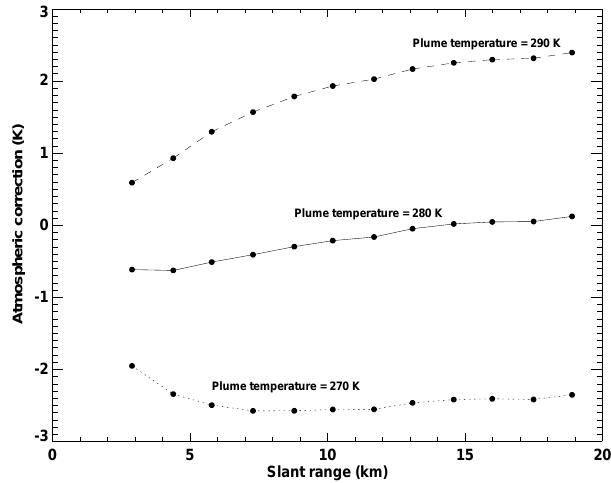
Figure 8. Atmospheric correction, T p – 8 10 (in K), as a function FIGURE 8. Atmospheric correction, T p – TB 10 (in K) as a function of the slant range to a plume at three different (uniform) temperatures ( T p ). Calculations were performed using MODTRAN-4 for the 10 (cid:22) m of the slant range to a plume at three different (uniform) temper- channel. atures ( T p ). Calculations were performed using MODTRAN-4 for the 10µm